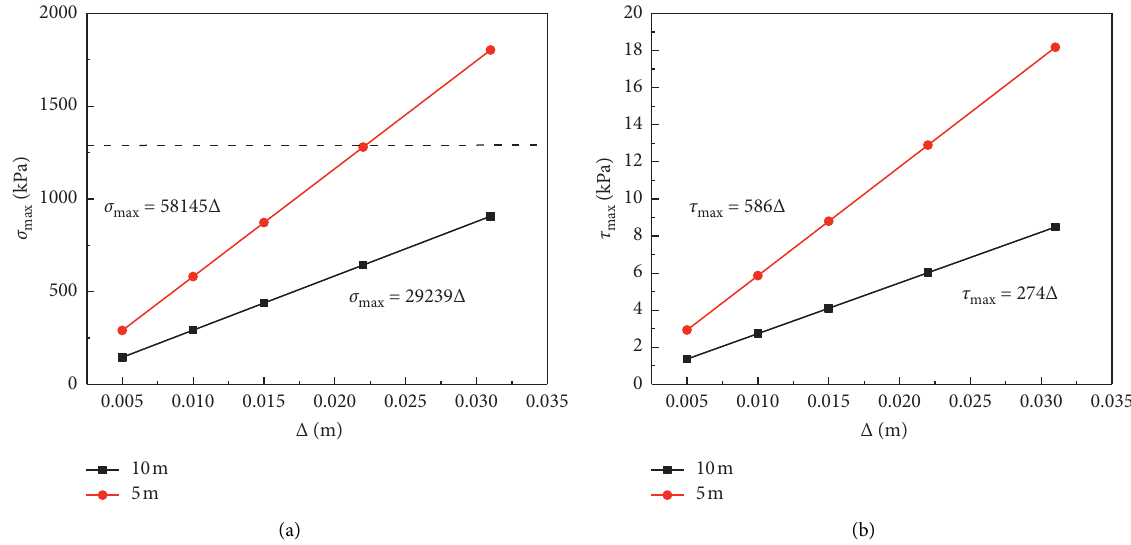
Figure 12: Effects of different frost heave amounts on the maximum normal stress (a) and maximum shear stress (b) of the dangerous section.